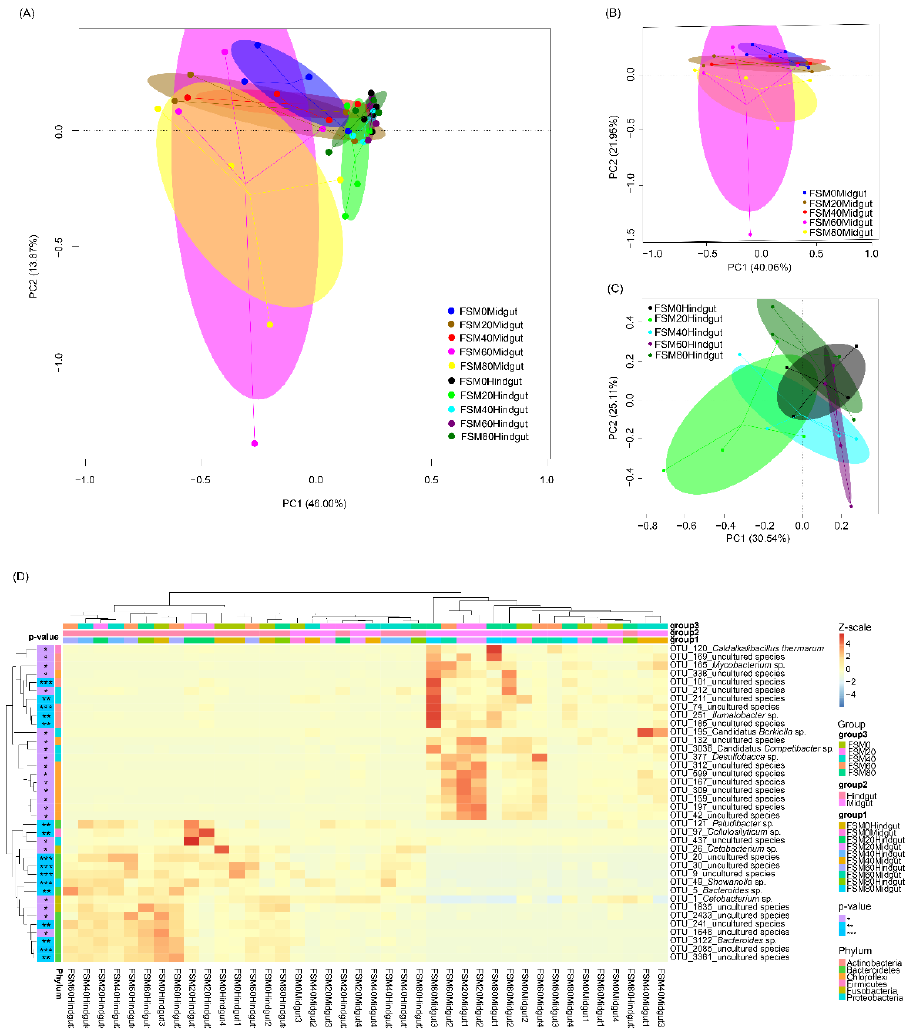
Figure 3. PCA and heatmap profiles of all samples. ( A ) midgut samples; ( B ) and hindgut samples; ( C ) heatmap profile of significantly different dominant OTUs in all samples. The numbers in the sample names indicate the proportion of fermented soybean meal (FSM) instead of fish meal. *, p < 0.05; **, p < 0.01; ***, p < 0.001.